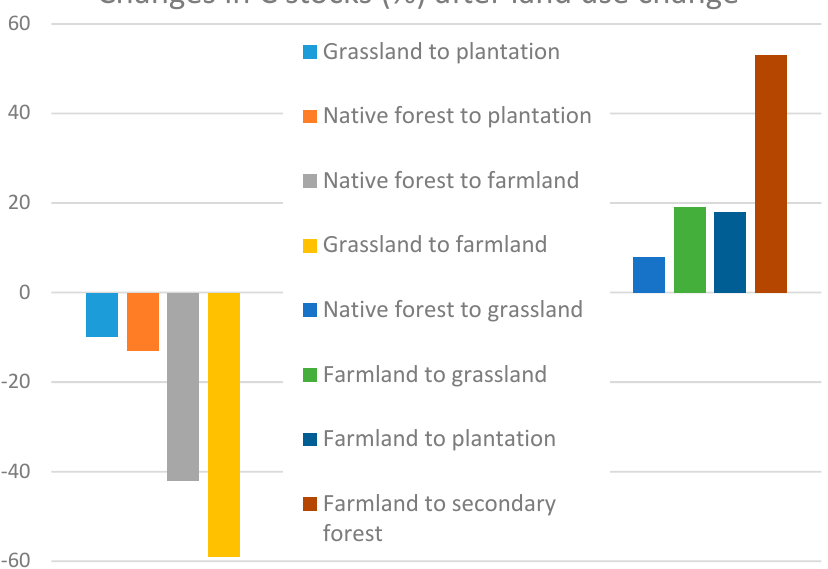
Figure 2. Changes in carbon stocks due to land use change based on Guo and Gifford (2002) [61].